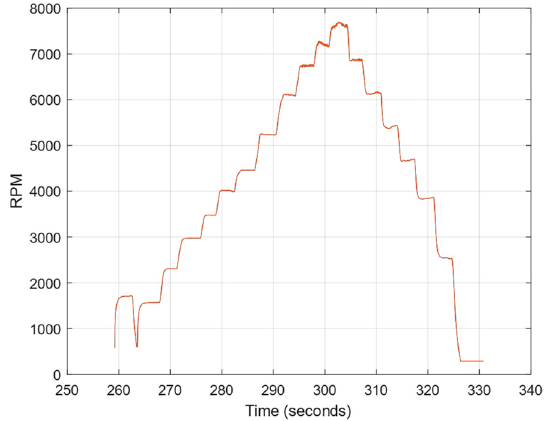
Figure 11. Experiment with RPM changes.